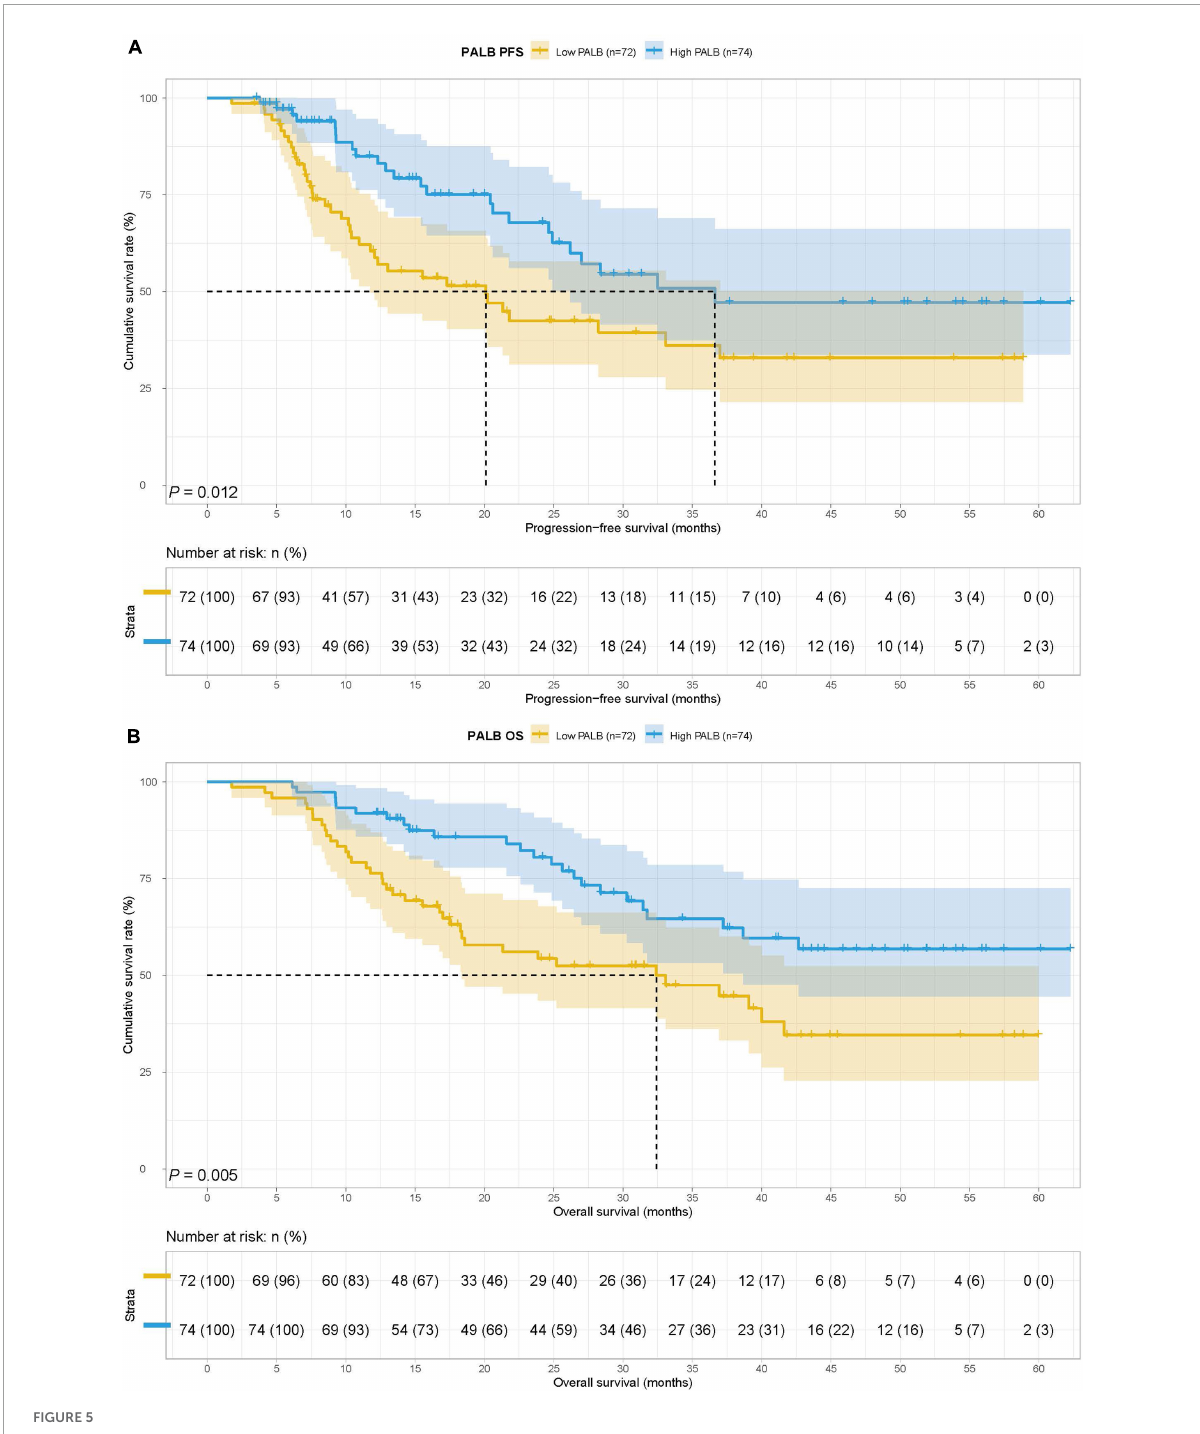
FIGURE5 Prealbumin (PALB) related survival curve of (A) PFS and (B) OS in all patients.